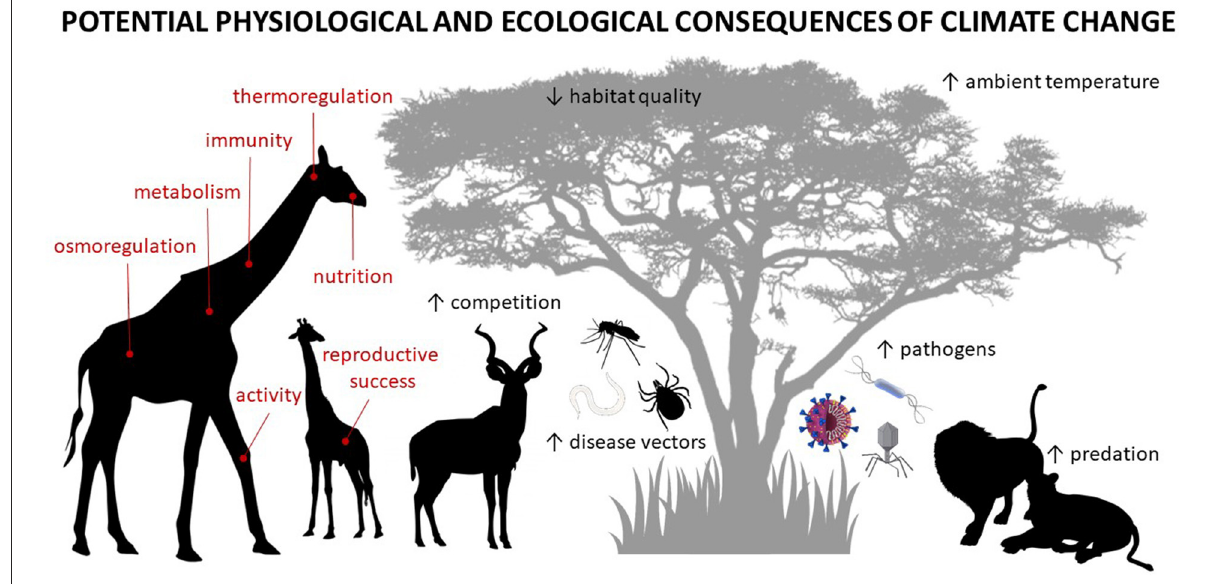
FIGURE1 Global climate change interacts with multiple determinants of the local environment to which an organism is adapted, including ambient temperature, habitat quality (food, water, refuge), and challenges from predators, competitors, and pathogens. Persistence requires the negative fitness consequences of disturbed physiological and behavioral systems to be overcome through successful adaptations selected at a rate commensurate with the rate of climate change. The papers in this Research Topic explore some of those interactions and their